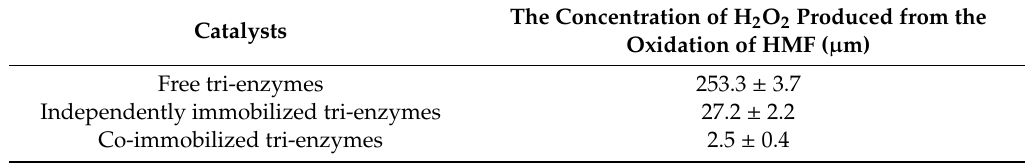
Table 5. Comparison of the level of H 2 O 2 produced during the oxidation of HMF catalyzed by free galactose oxidase, independently immobilized galactose oxidase, and co-immobilized galactose oxidase. The Concentration of H 2 O 2 Produced from Catalysts